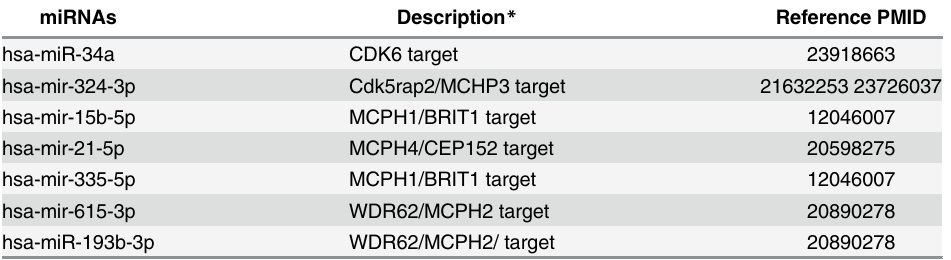
Table 2. Examples of human miRNAs with sequence complementary to ZIKV